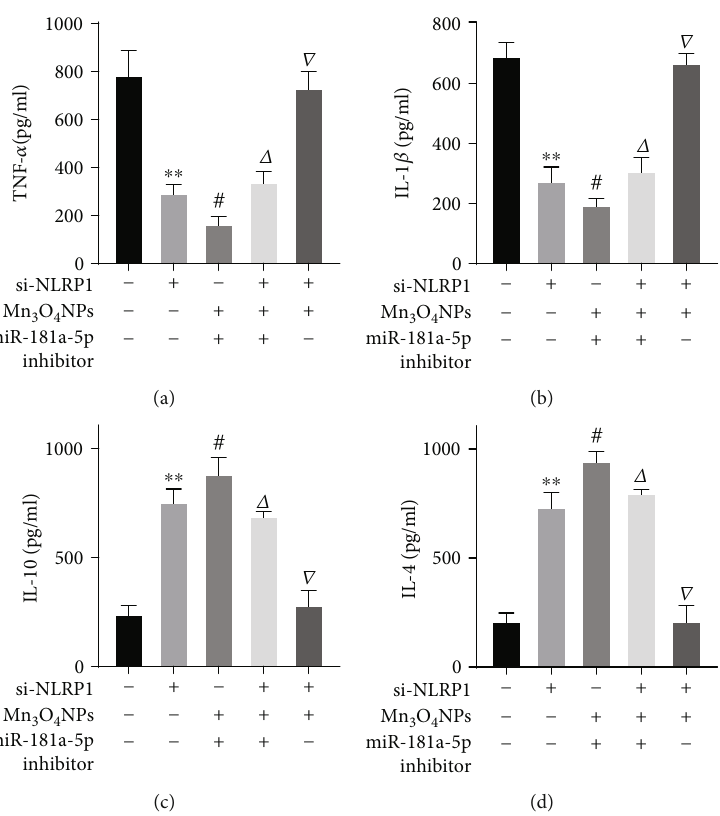
Figure 5: Mechanism of Mn O nanoparticles e ff ect on the in fl ammatory factors levels in human tendon cells induced by LPS. (a) TNF- α 3 4 level measured by ELISA. (b) IL-1 β level measured by ELISA. (c) IL-4 level measured by ELISA. (d) IL-10 level measured by ELISA. ∗∗ P < 0 : 01 vs. NC group; # P < 0 : 05 vs. si-NLRP1 group; Δ P < 0 : 05 vs. si-NLRP1+Mn +Mn O NPs+miR-181a-5p inhibitor 3 4